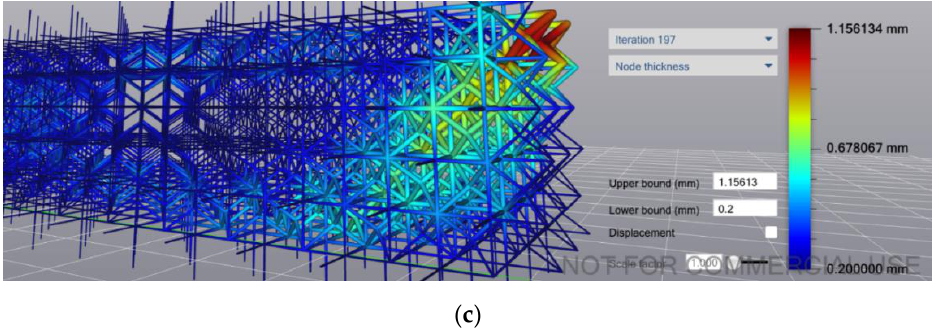
Figure 7. Three methods of prescribing cell thickness: ( a ) global prescription of a thickness value, ( b ) thickness specified in terms of a function, and ( c ) thickness optimized by the solver in response to local stresses (screen captures using nTopology software [9]).